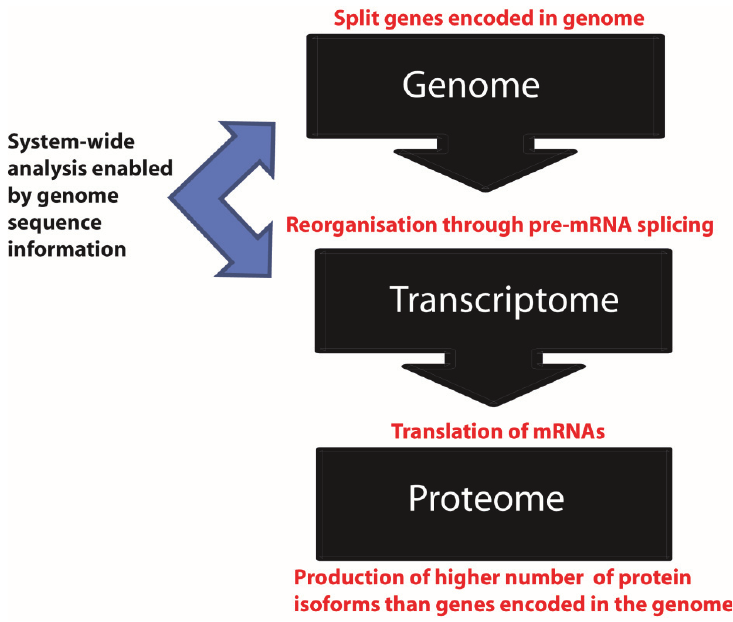
Figure 1. Information flow from the genome to the proteome. The genome represents an archive of information embedded in DNA. This information is transcribed as RNA to give the transcriptome, and then translated into protein to give the